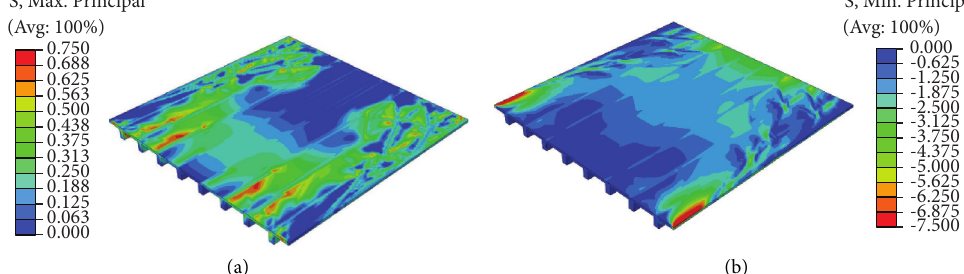
Figure 13: Distribution of main maximum and minimum stresses for a model with loading in Z direction (MPa) at displacement equivalent to maximum strength. (a) Maximum principal stress distribution in concrete slab (MPa). (b) Distribution of minimum stress in concrete slab (MPa).